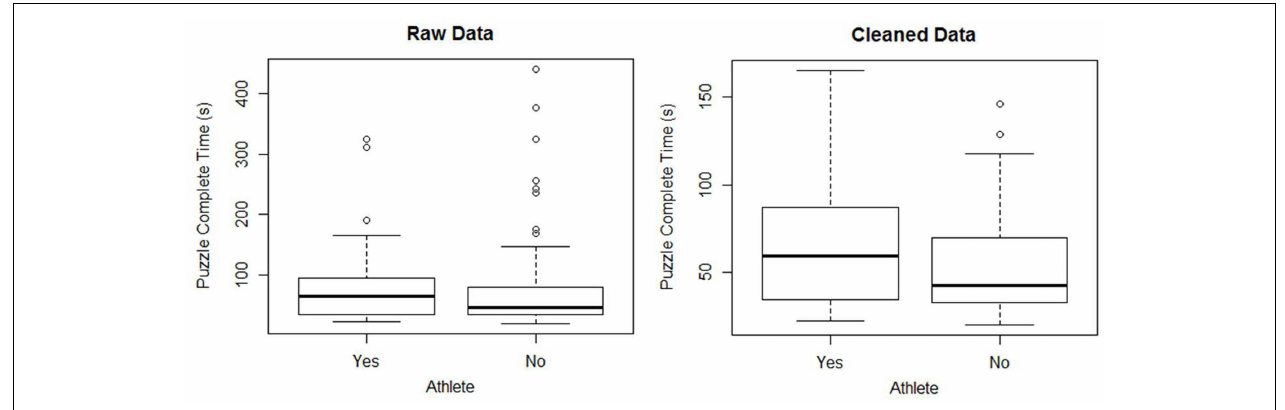
FIGURE 2 | Side-by-side boxplots of the completion time of theTangrams game for raw and cleaned data.